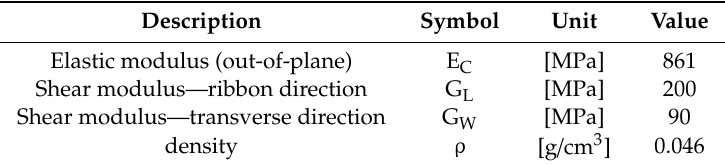
Table 2. Honeycomb mechanical properties